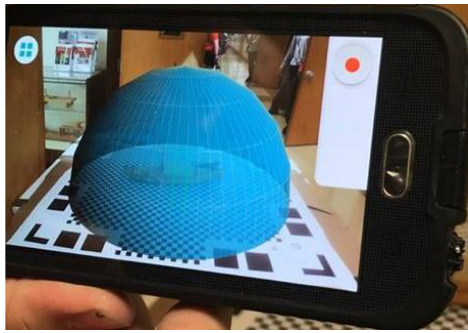
Figure 4. Large Junk Model being scanned with Qlone Application on Samsung Galaxy S6 Cell Phone